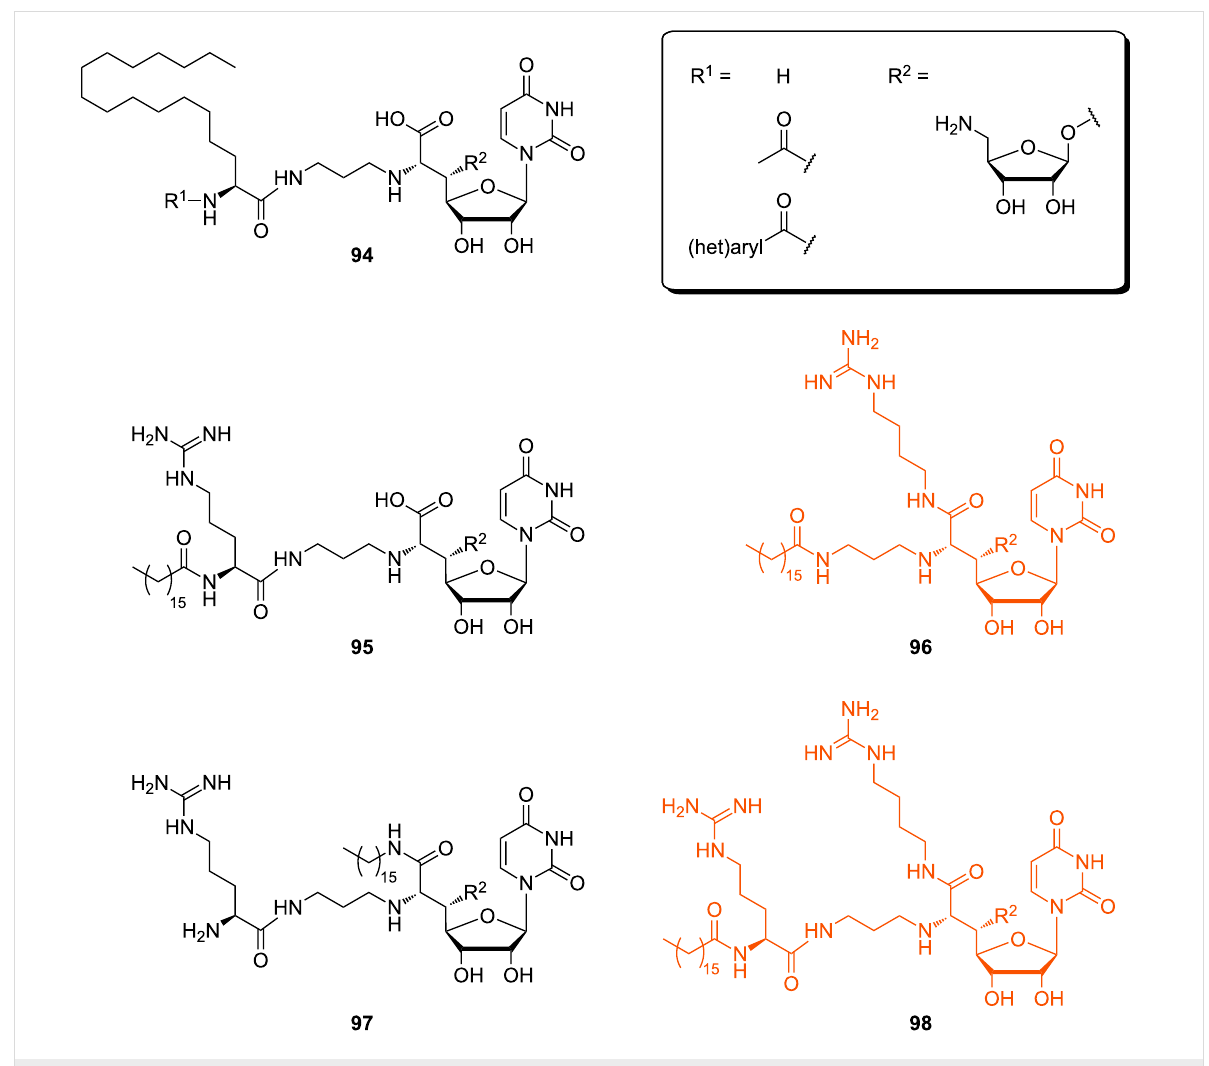
Figure 12: Muraymycin analogues designed for potential anti- Pseudomonas activity (most active analogues are highlighted in orange) [115].